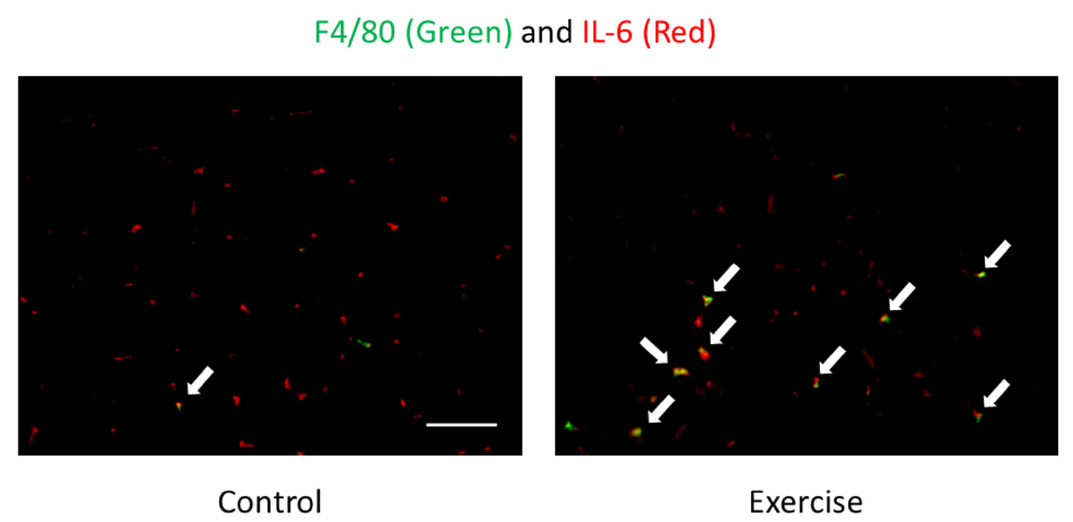
Figure 2. Localization of F4/80 (monocytes/macrophages) (green) and IL-6 (red) of skeletal muscle after exercise detected by immunofluorescence staining [7,40]. Arrows (yellow) indicate F4/80 and IL-6 double positive cells. The signals of IL-6 were mainly observed in the interstitial space. Exercise increased F4/80 and IL-6 double positive cells but not IL-6 positive myocytes, suggesting that IL-6 is produced by immune cells. Scale bar is 100 µm.